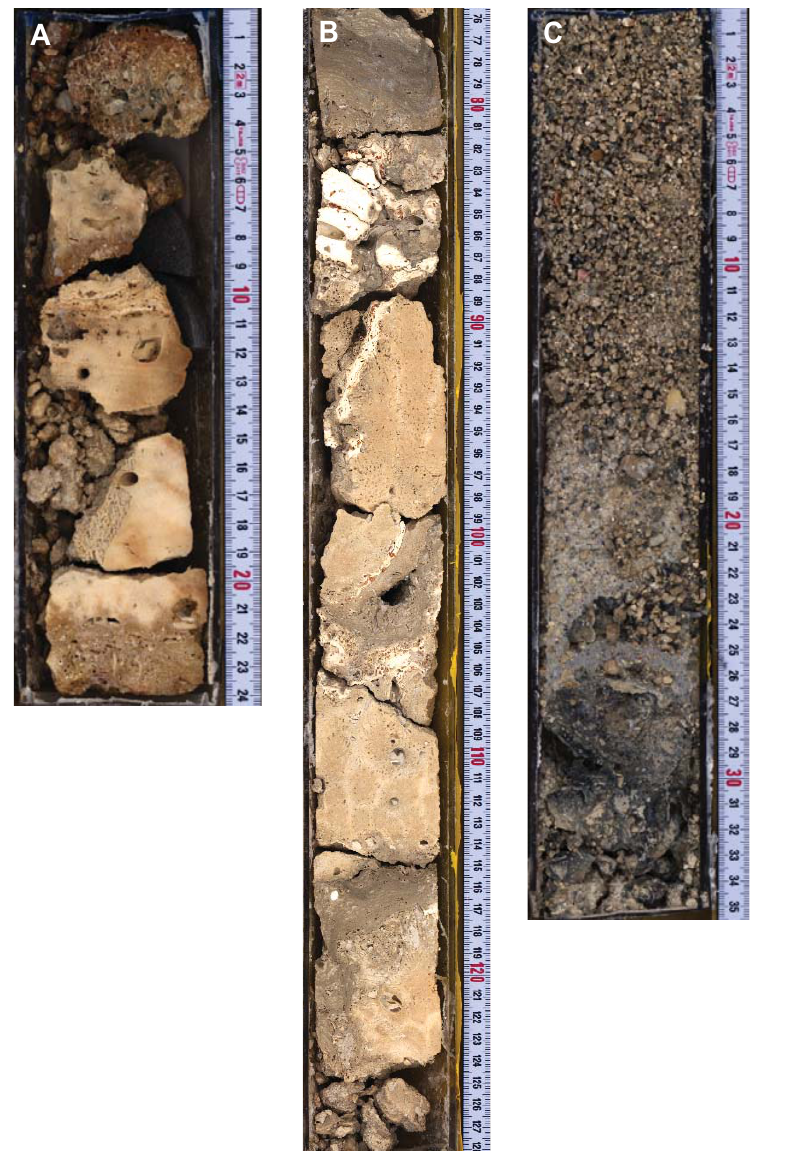
Figure 3. Representative litholostratigraphic succession from the fossil coral reef terraces (M0033A). The section was obtained from R1 (~90 mbsl) and contains coralgal boundstones typically found at the top of the reef structure [A]. Coralgal-microbialite boundstones were recovered from R5 (98 mbsl) from the same hole [B] and packstone together with unlithfied sediments sequence obtained from deeper part of the section (R21) at approximately 129 mbsl